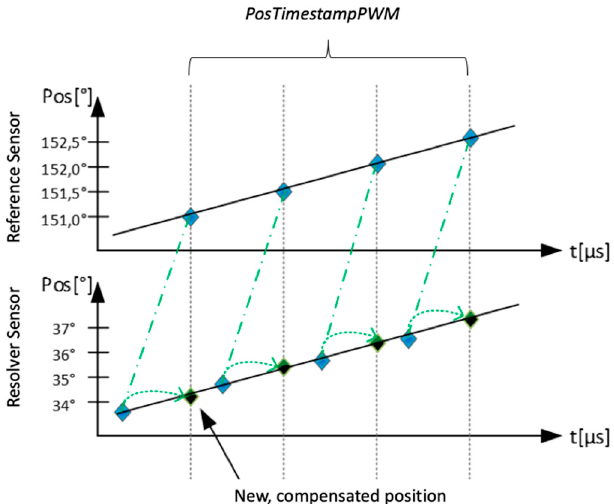
Figure 15. Angular correction method of the resolver angle under consideration of lagging DSADC timestamp. Shown here are both sensor angular outputs over time ( top : reference sensor, bottom : resolver) and the compensated DUT angle.